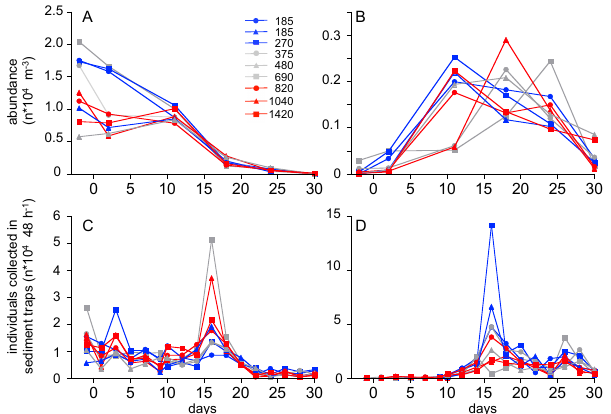
Fig. 6. Development of the Cirripedia abundance in the mesocosms. (A) (nauplii) and (B) (cypris larvae) present data from the water col- umn; (C) (nauplii) and (D) (cypris larvae) present data from the sed- iment trap samples. The numbers given in the legend present initial CO 2 concentrations (µatm) in the mesocosms after the CO 2 manip- ulation was completed. Please note that the scales are different.